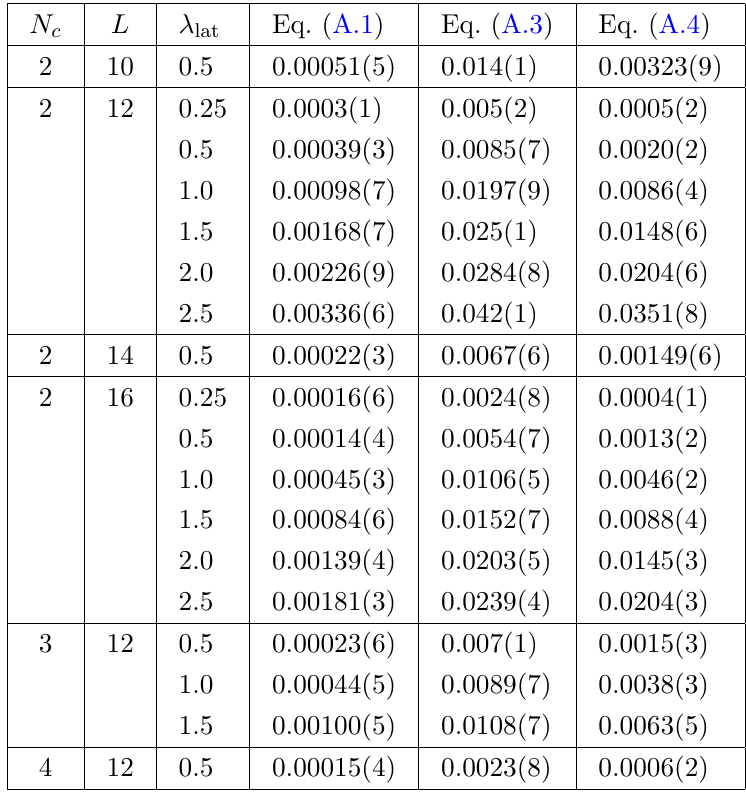
Table 3. Additional information about the ensembles summarized in table 1. These violations of the three Q Ward identities discussed in the text contain complementary information about the approach to the continuum limit. As expected [11], the violations decrease as λ lat decreases, as L increases, and as N c